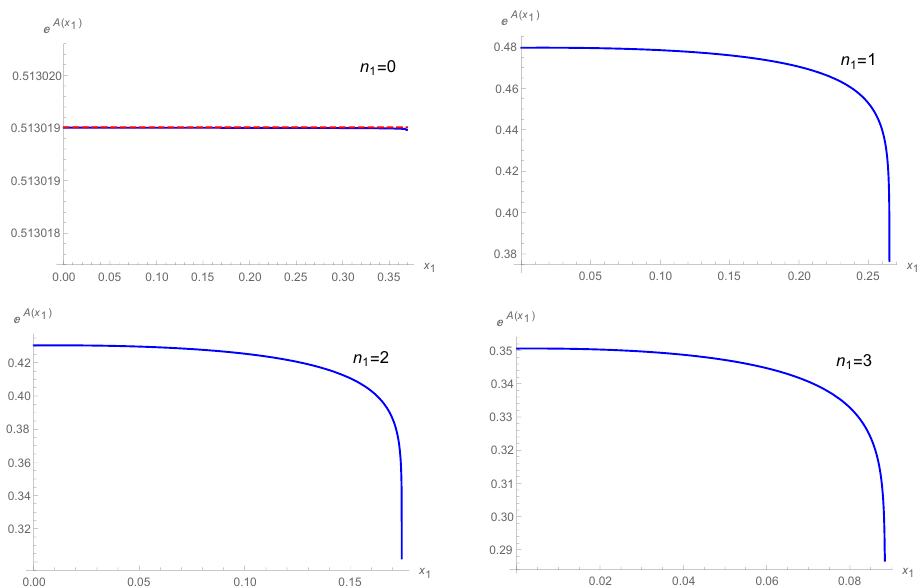
Figure 2 . ( f 0 ; f 1 ; f 2 ; f 3 ; c 1 ; c 2 ; k ) = (2 ; 1 ; 1 ; 2 ; 4 ; 1 ; 1) and u 1 = 2: note that, in the upper-left panel for n 1 = 0, the numerical plot (blue) matches the constant value of e A ( x 1 ) from the exact quadratic polynomial solution U ( x 1 ) = (cid:0) 173 x 1 ( x 1 (cid:0) x R ) (red, dashed). 32 (cid:12)gure 1 and therefore we have j U 0 ( x ) j = j U 0 ( x ) j = 2. This guarantees that the conical L R singularities at x = x ; x can be removed provided that the period of the coordinate (cid:30) 1 L R is chosen as 2 (cid:25)